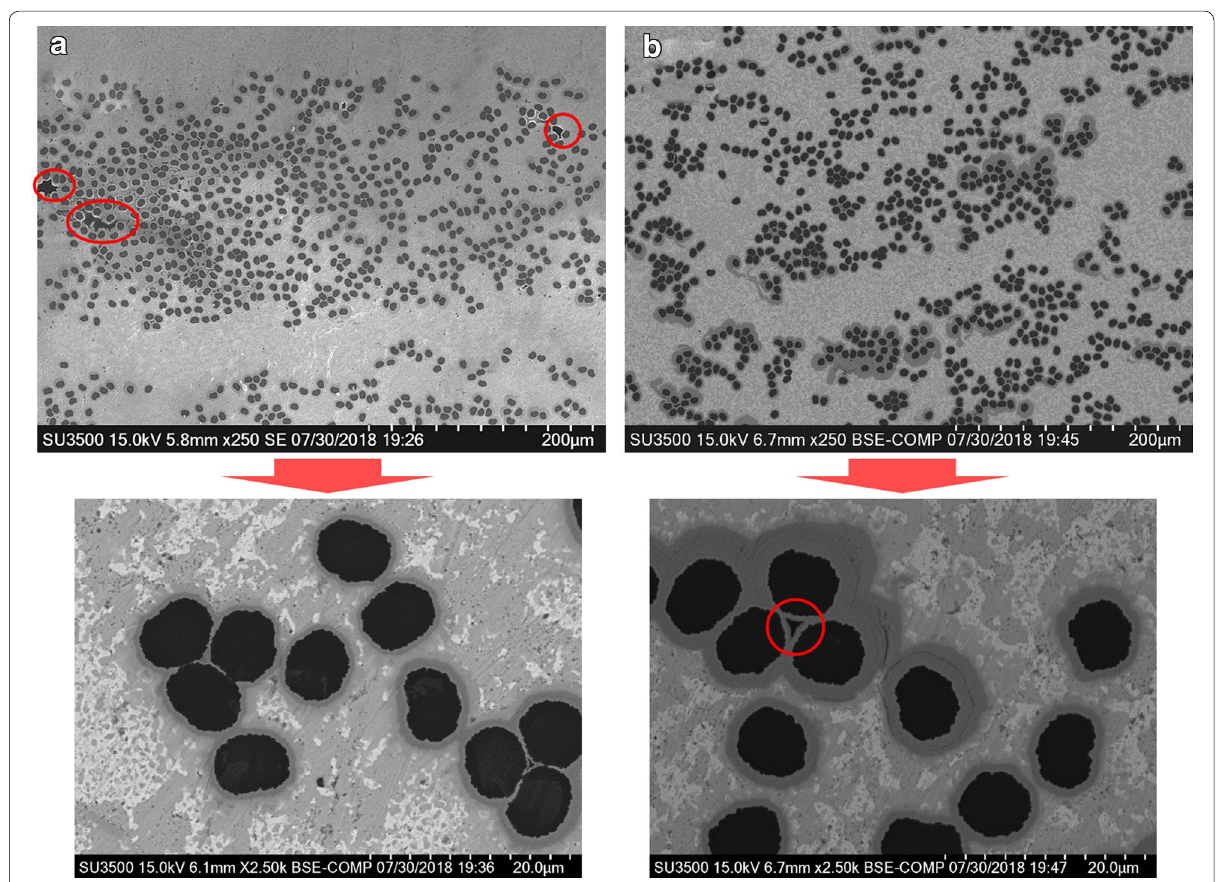
Figure 8 The interfacial microstructure of ( a ) 1 μm Cu coating specimen and ( b ) 3 μm Cu coating specimen